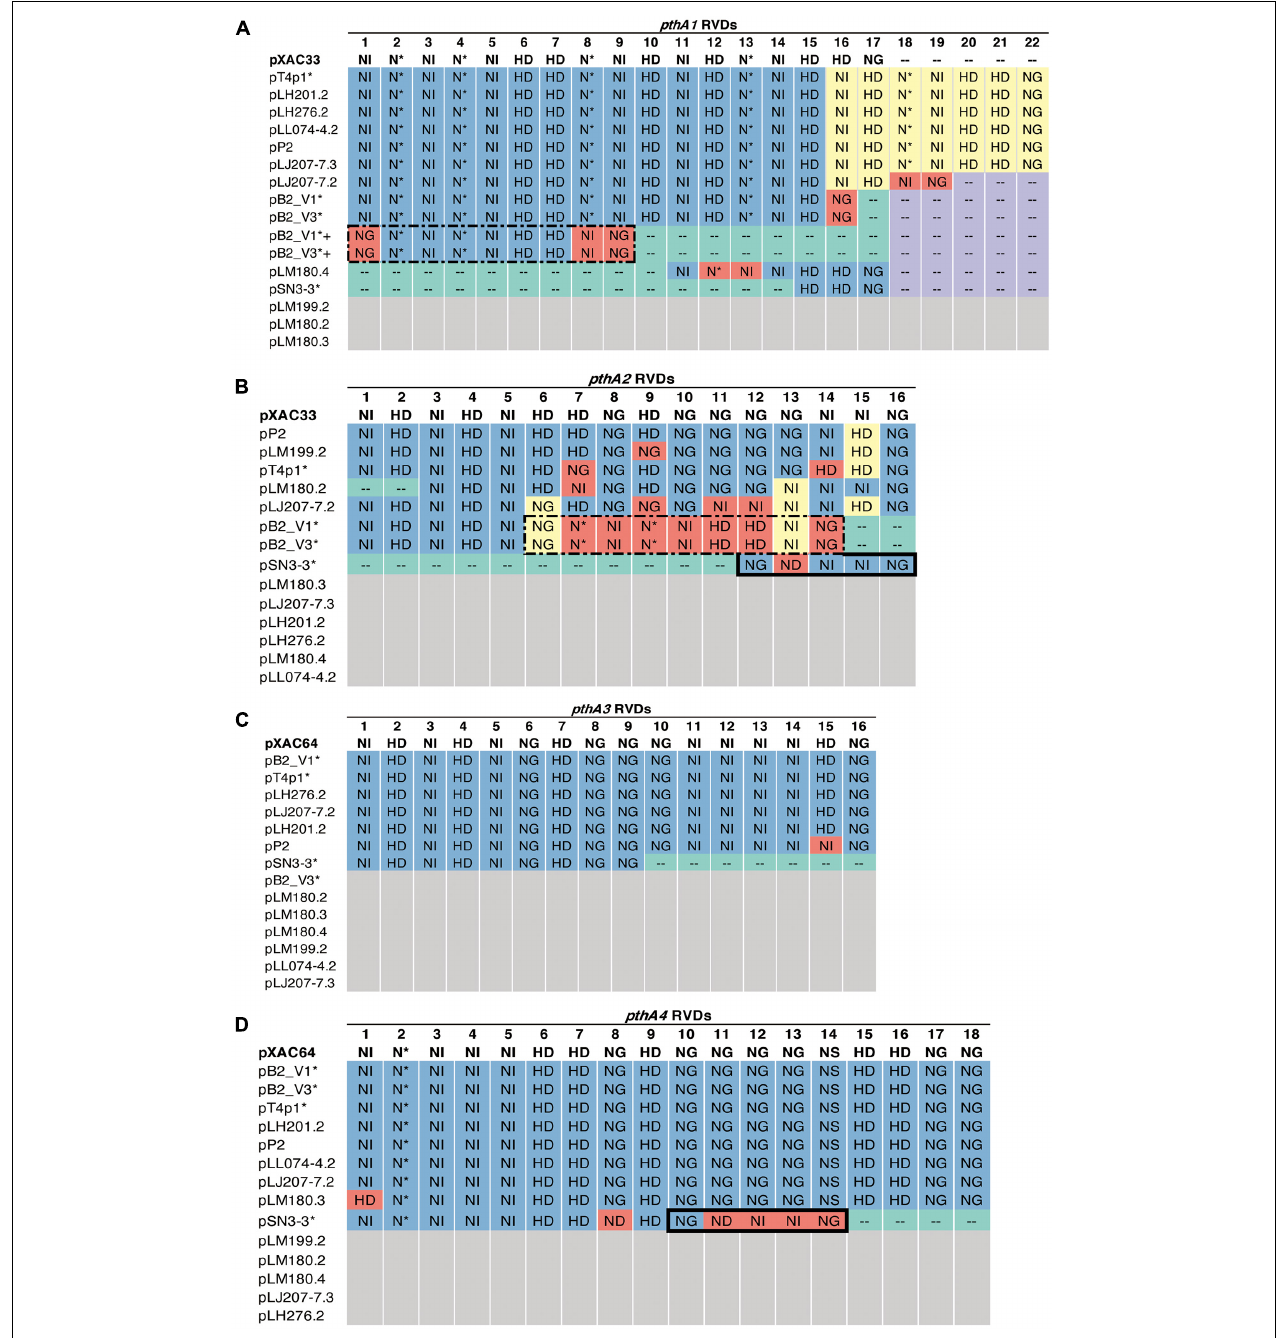
FIGURE 5 | RVD profile of pthA genes. The asterisks (*) indicate plasmids sequenced in this study. NI (Asn-Ile) recognizes A; HD (His-Asp) recognizes C (but not 5 (cid:48) -methyl-C); NG (Asn-Gly) recognizes T and 5 (cid:48) -methyl-C; NN (Asn-Asn) recognizes G or A; NS (Asn-Ser) recognizes A,T,C or G; N* (Asn-*) recognizes C or T [47]. Blue: identical to the reference. Purple: absent, the same as the reference. Green: absent, different from the reference. Yellow: > 50% sequence similarity with the reference. Red: unique. White: no such pthA genes. (A) Plus sign (+): merged pthA genes. (A,B) Dashed box: nine pthA1 repeats were merged with pthA2 repeats. (B,D) Solid box: five pthA2 repeats were merged with pthA4